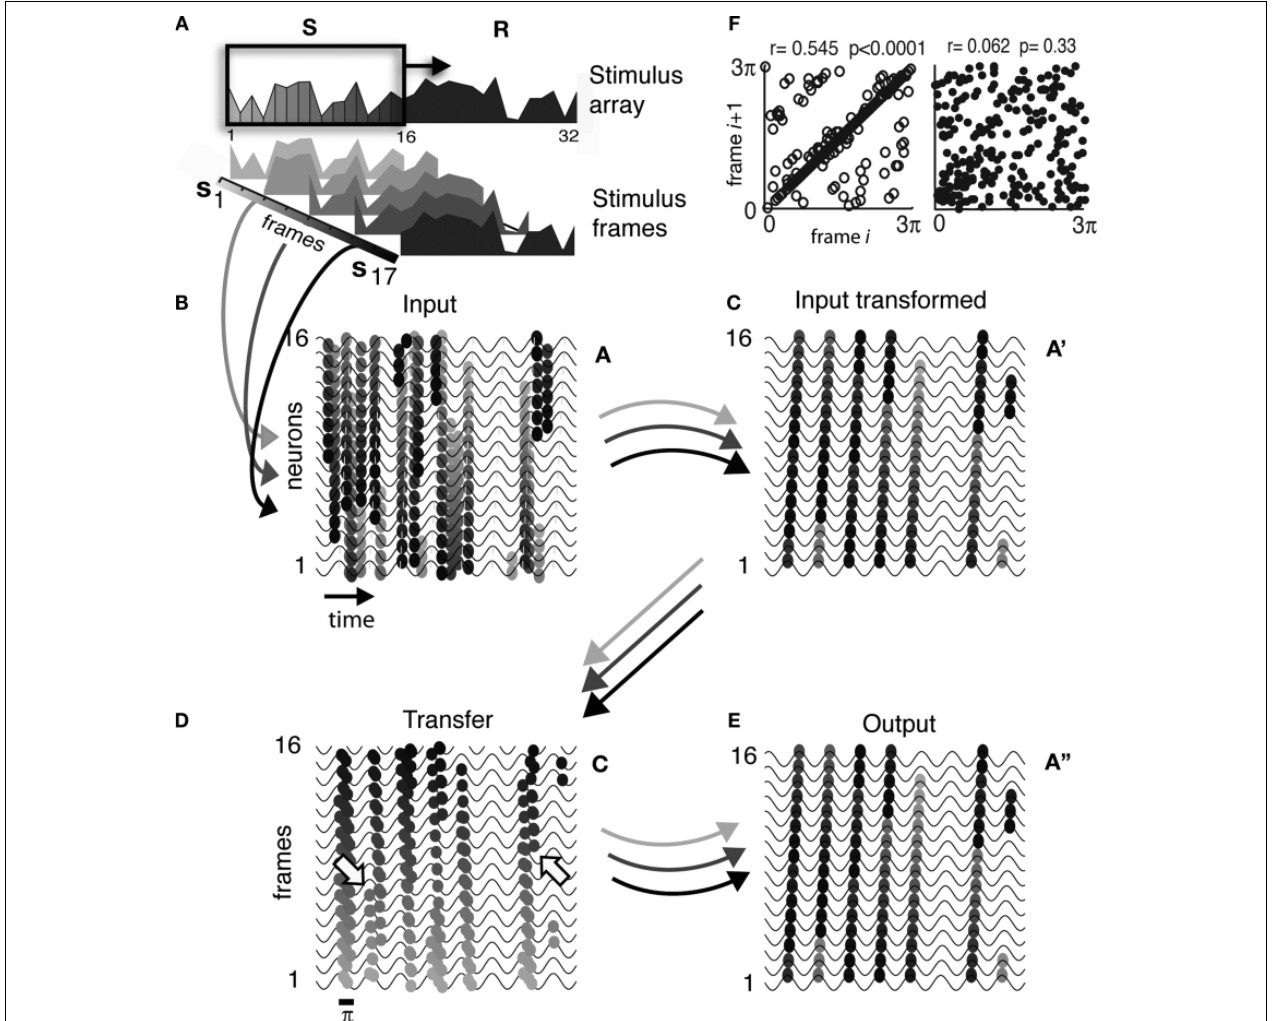
arrows) at points where APs from a new frame are assigned to the next gamma cycle. (E) Superimposed traces of the reconstructed patterns. (F) Return plots represent the recurrence of AP-times from frame i to frame i + 1. The left return plot was calculated from the AP pattern in (D) when stimulus (A) was presented. The right return plot was calculated from an example where consecutive frames were uncorrelated. Although each neuron processed different input from every frame, the temporal patterns of APs across successive frames were highly correlated (left). In contrast, when input frames were random and independent from one another the AP patterns became uncorrelated (right). Both plots contain the same number of data points. AP latencies were wrapped around 3 π . (The r and P values are shown above the